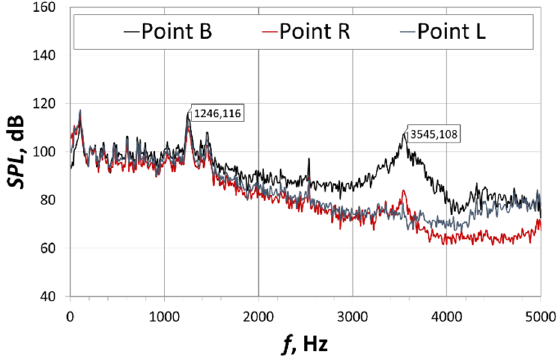
Figure 17. Spectral analysis of SPL for velocity equal to 60 m/s—experimental data.